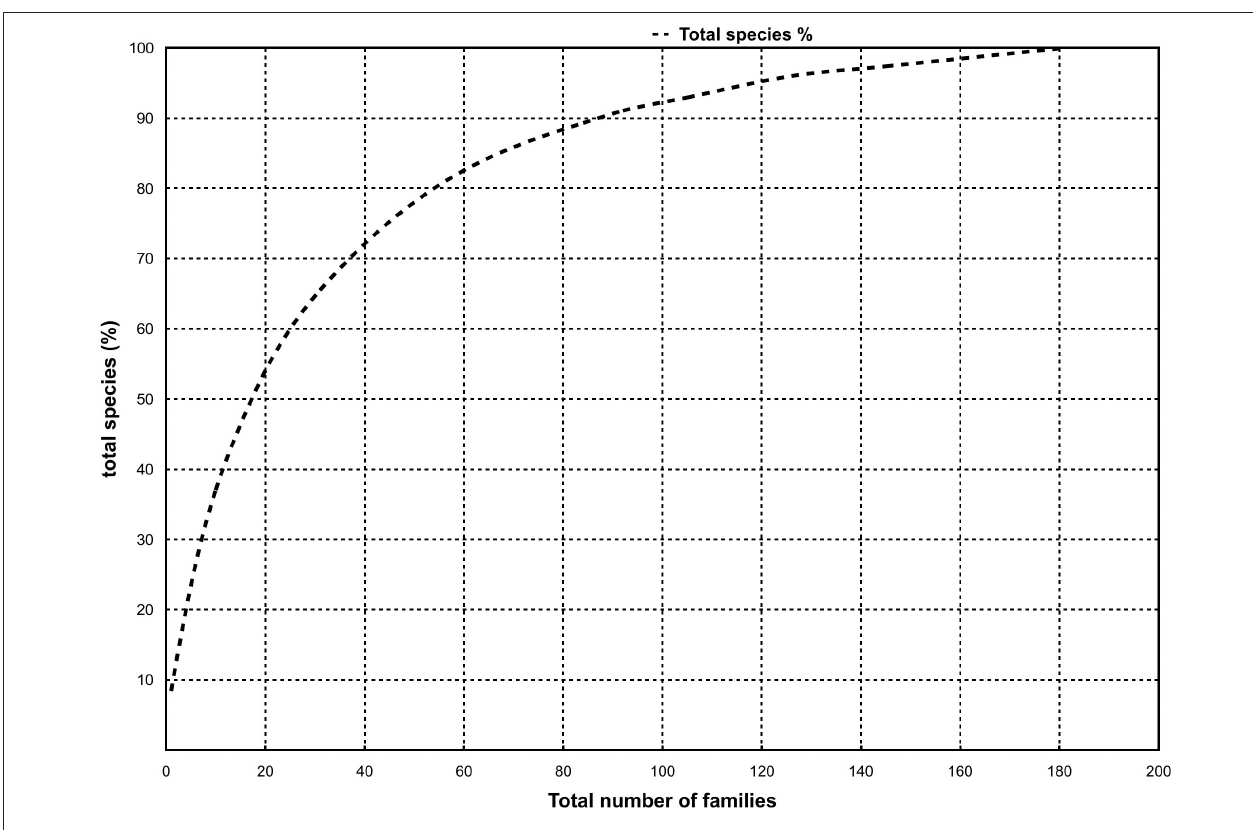
FIGURE 3 | Contribution of families to the total species pool